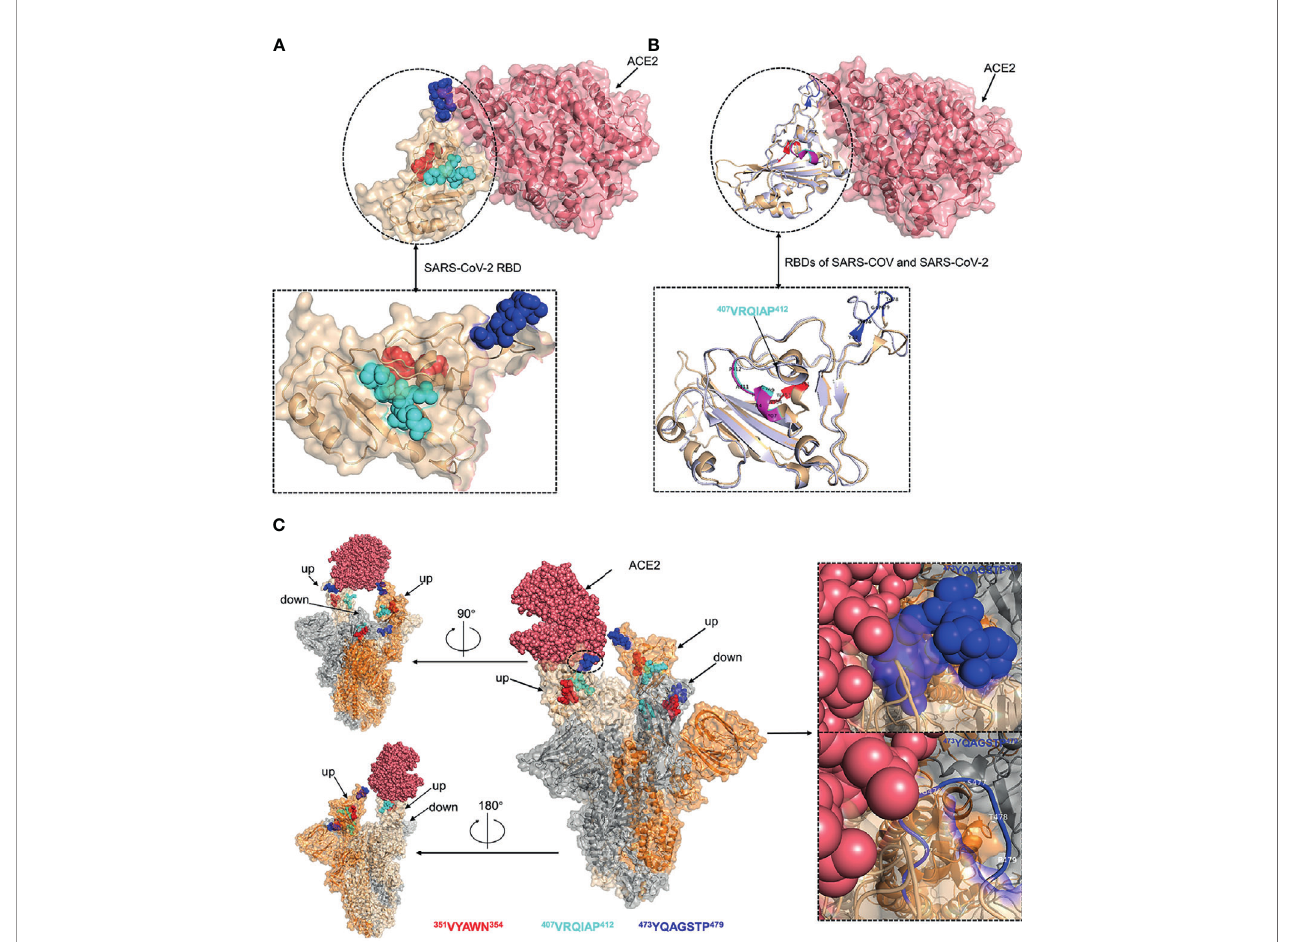
FIGURE 7 | Structural analysis of the identi fi ed linear B-cell epitopes. (A) The linear B-cell epitopes were mapped on the structure of SARS-CoV-2 RBD-ACE2 complex (PDB ID: 6M0J). Inset was a zoomed-in view of the SARS-CoV-2 RBD. (B) The structure of SARS-CoV RBD-ACE2 complex (PDB ID: 2AJF) was superimposed with the structure of SARS-CoV-2 RBD-ACE2 complex (PDB ID: 6M0J). Cartoon representation of the RBDs of SARS-CoV and SARS-CoV-2. Inset was a zoomed-in view of the RBDs of SARS-CoV and SARS-CoV-2. (C) The localization of identi fi ed epitopes mapped on SARS-CoV-2 S trimer (PDB ID: 7A95). Two RBDs in the open state and one RBD in the closed state. The S monomer con fi gured ‘ up ’ and complexed with ACE2 was colored as wheat. The other ‘ up ’ con fi gured S monomer was colored as orange. The S monomer in the closed state was colored as grey. Insets were zoomed-in views of the localization of epitope 473 YQAGSTP 479 . Throughout the whole fi gure, SARS-CoV RBD (whiteblue), SARS-CoV-2 RBD (wheat), ACE2 (salmon pink), epitope 407 VRQIAP 412 on SARS-CoV RBD (magentas), epitope 407 VRQIAP 412 on SARS-CoV-2 RBD (cyan), epitope 350 VYAWN 354 (red), epitope 473 YQAGSTP 479